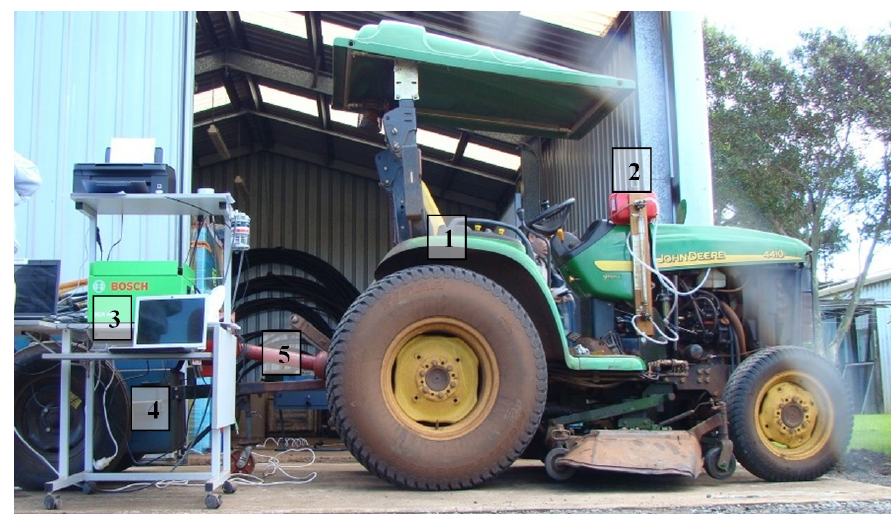
Figure 1. The experiment setup: ( 1 ) the tractor; ( 2 ) fuel system; ( 3 ) gas analyzer; ( 4 ) dynamometer; ( 5 ) PTO connecting